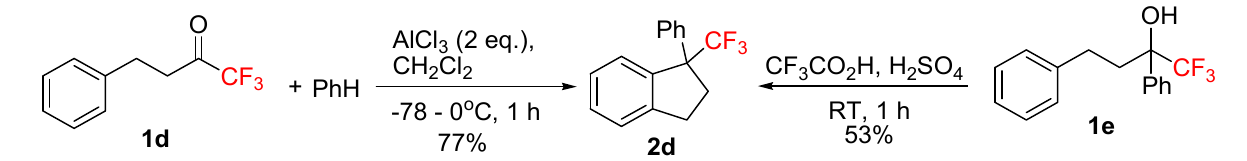
Scheme 2. Synthesis of 1-CF 3 -indane 2d from CF 3 -ketone 1d or from CF 3 -alcohol 1e . Remarkably, indanol 2c under the same protosolvolytic conditions in CF 3 CO 2 H,